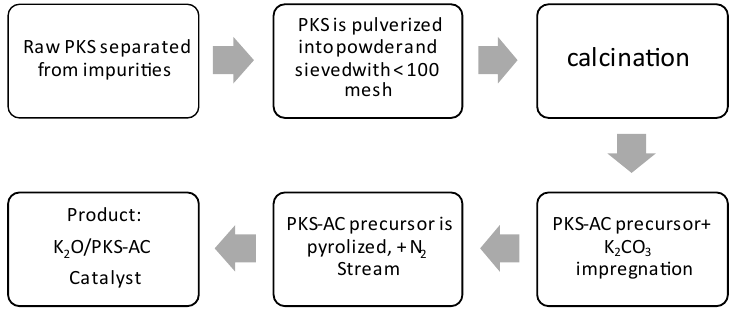
Figure 1. Schematic of the main process during K 2 O/PKS-AC catalyst preparation.